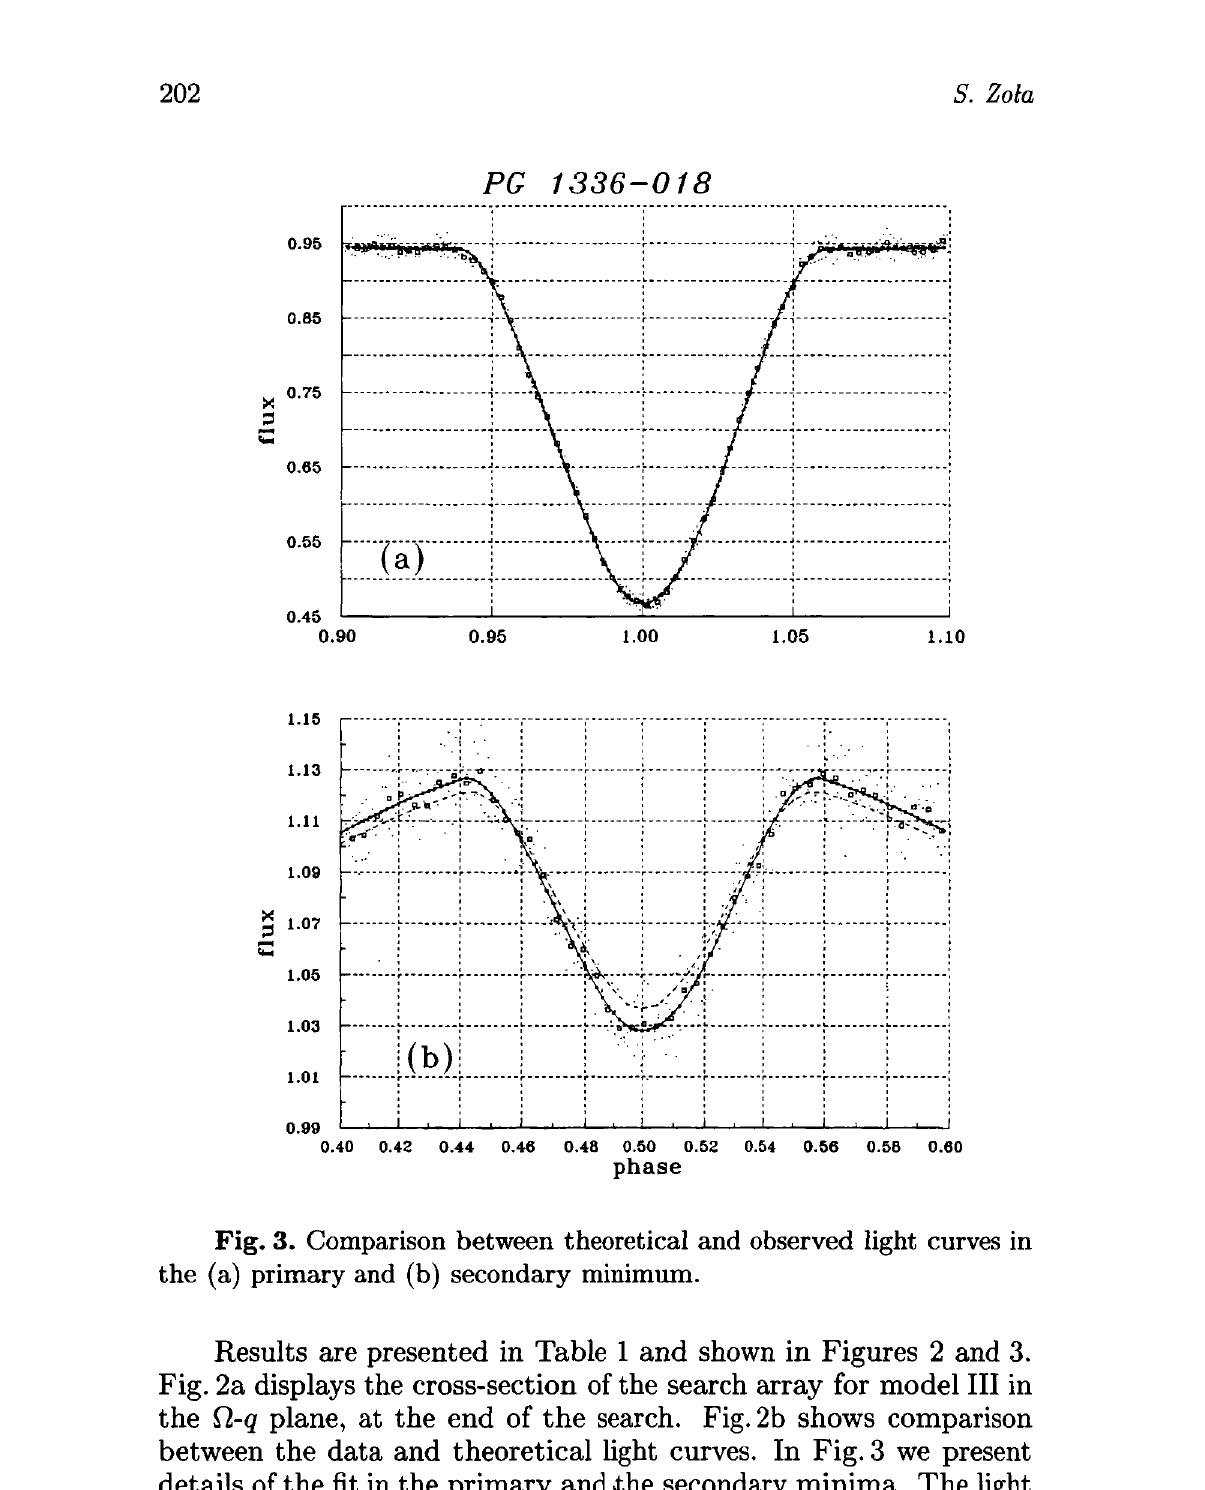
Fig. 3. Comparison between theoretical and observed light curves in the (a) primary and (b) secondary